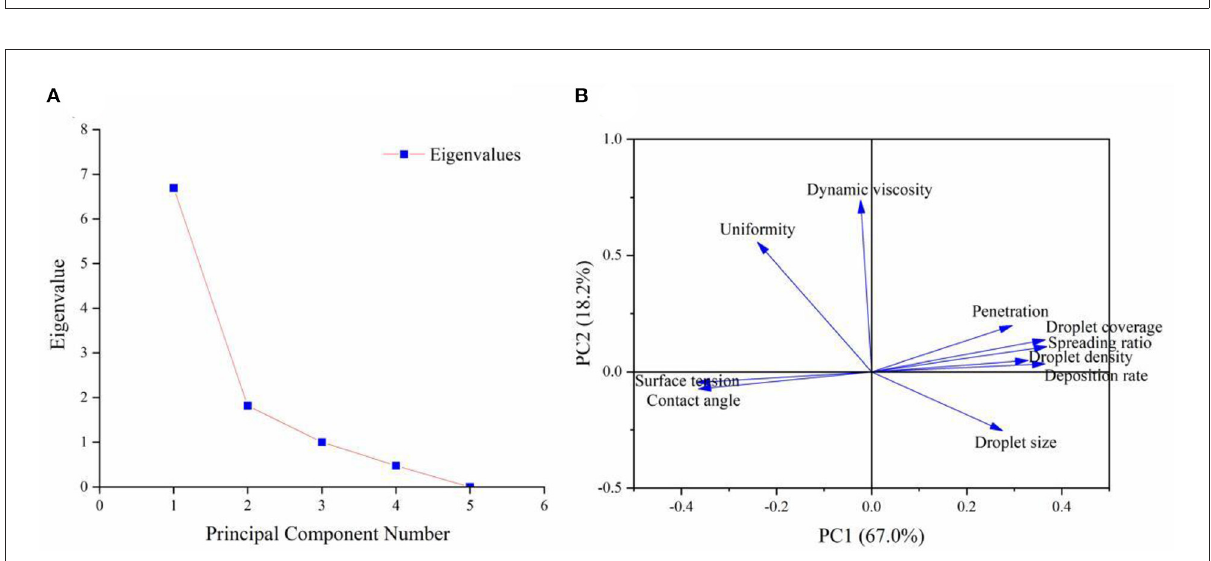
FIGURE9 Heat map for the pearson correlation coefficients. The color and size of the circles represent the r and p- values. Deep and large circle signal a significant correlation.